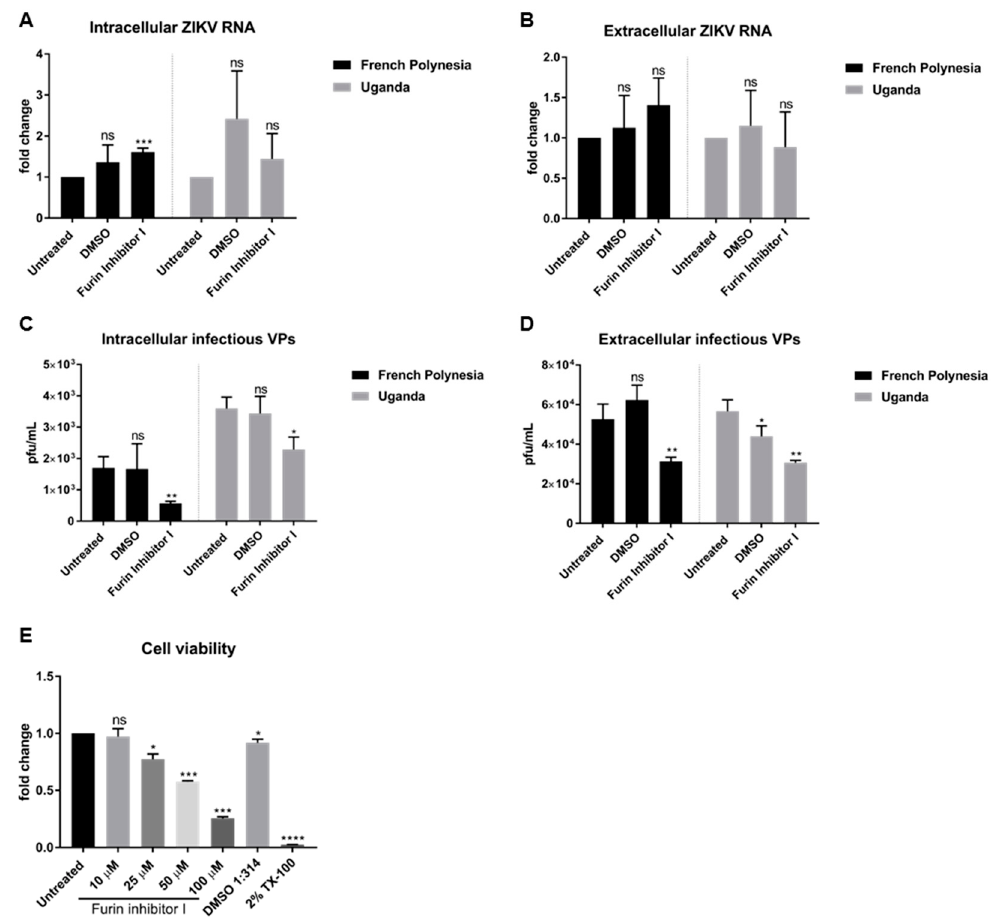
Figure 4. Furin inhibitor I diminishes ZIKV infectivity in A549 cells. ( A ) Quantification of the amount of intracellular ZIKV RNA of A549 cells infected with either the French Polynesia or the Uganda strain for 72 h and treated with 10 µ M furin inhibitor I (24 h treatment). Quantification was performed by RT-qPCR and the amount of ZIKV RNA was normalized to the amount of the RPL27 transcripts. DMSO was included as vehicle control and infected untreated cells were used as control; ( B ) Quantification of the amount of extracellular ZIKV RNA of A549 cells infected with either the French Polynesia or the Uganda strain for 72 h and treated with 10 µ M furin inhibitor I (24 h treatment). Quantification was performed by RT-qPCR. DMSO was used as vehicle control and infected untreated cells served as control; ( C ) Quantification of the number of intracellular infectious viral particles (VPs) from A549 cells infected with either the French Polynesia or the Uganda strain for 72 h and treated with 10 µ M furin inhibitor I (24 h treatment). Quantification was performed in Vero cells by plaque assay and the number of infectious viral particles is expressed in plaques forming units per mL (pfu / mL). DMSO was used and vehicle control and infected untreated cells served as control; ( D ) Quantification of the number of extracellular infectious viral particles (VPs) from A549 cells infected with either the French Polynesia or the Uganda strain for 72 h and treated with 10 µ M furin inhibitor I (24 h treatment). Quantification was performed in Vero cells by plaque assay and the number of infectious viral particles is expressed in plaques forming units per mL (pfu / mL). DMSO was used as vehicle control and infected untreated cells served as control; ( E ) A549 cells were treated with di ff erent concentrations of furin inhibitor I during 24 h and cell viability was quantified by PrestoBlue assay. Cells treated with DMSO 1:314 and 2% Triton X-100 (TX-100) served as vehicle control for the chosen concentration and positive control, respectively. Untreated cells were used for normalization. ns = not significant p > 0.05; * p ≤ 0.05; ** p ≤ 0.01; *** p ≤ 0.001; **** p ≤